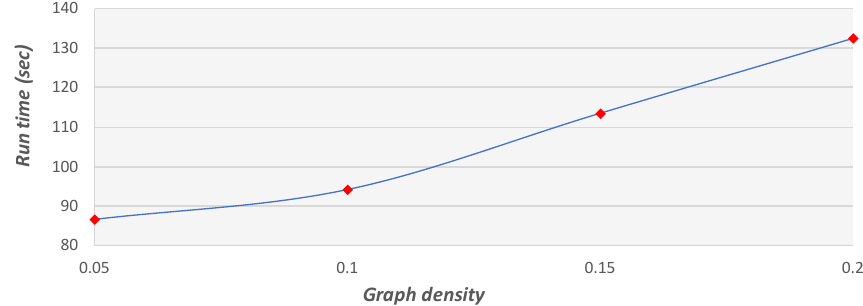
Figure 22. Run time of the GA on graphs with 4000 vertices at different